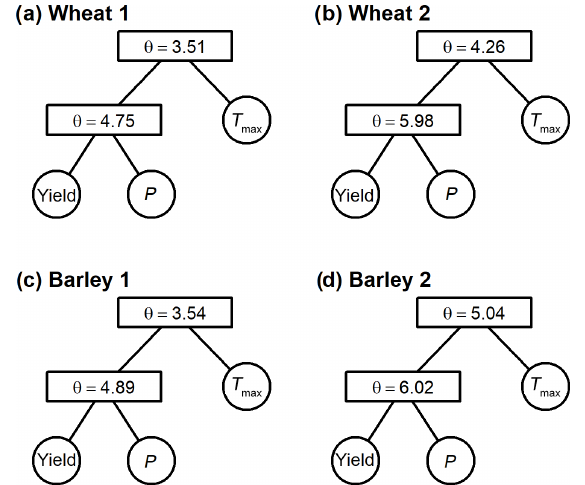
Figure 3. Structure and respective parameters of the selected nested Frank models C 1 (C 12 (u 1 ,u 2 ; θ 12 ),u 3 ; θ 1 ) to model the trivari- ate joint distributions between crop yields, P MAM and T max